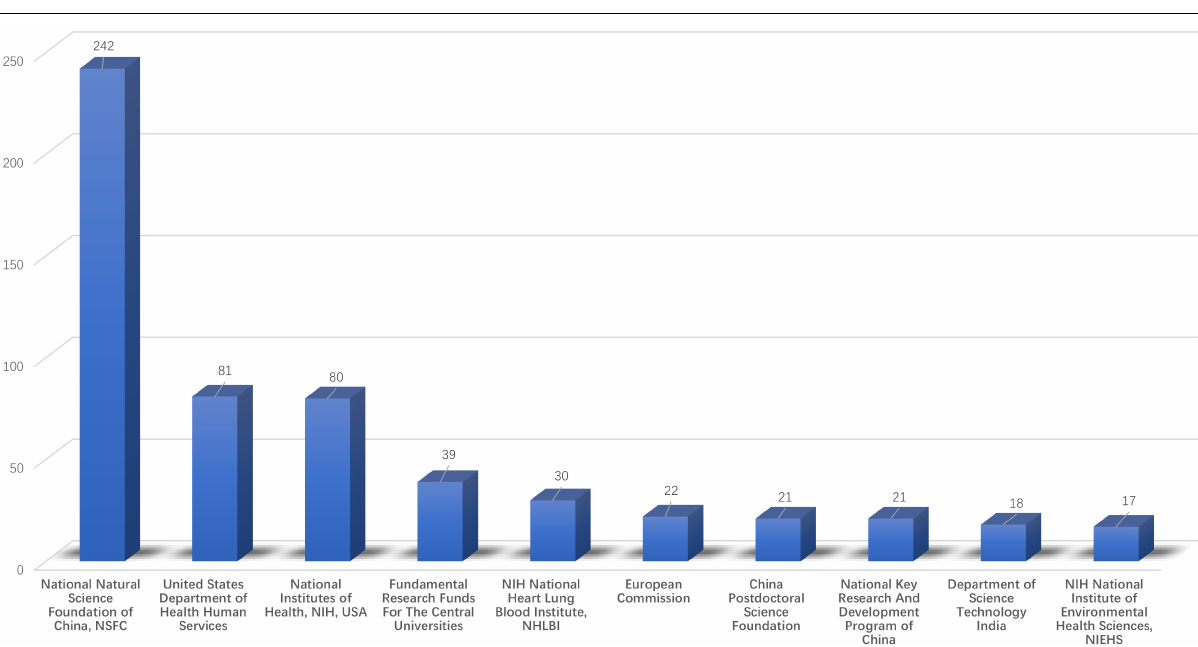
FIGURE 4 | Distribution of articles by funding agencies (top 10 funding